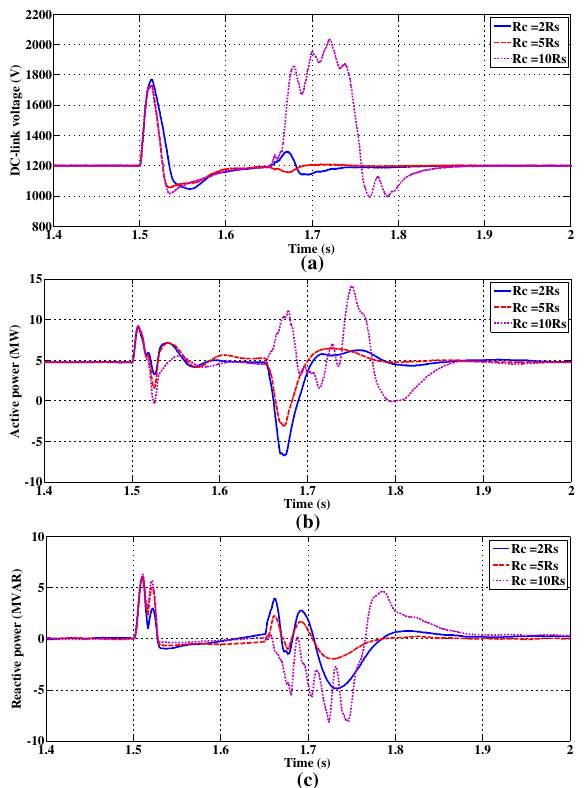
Fig. 14 Variation of measured values during three-phase to ground fault with different CBFT resistances ( a ) DC-link voltage; ( b ) active power; ( c ) reactive